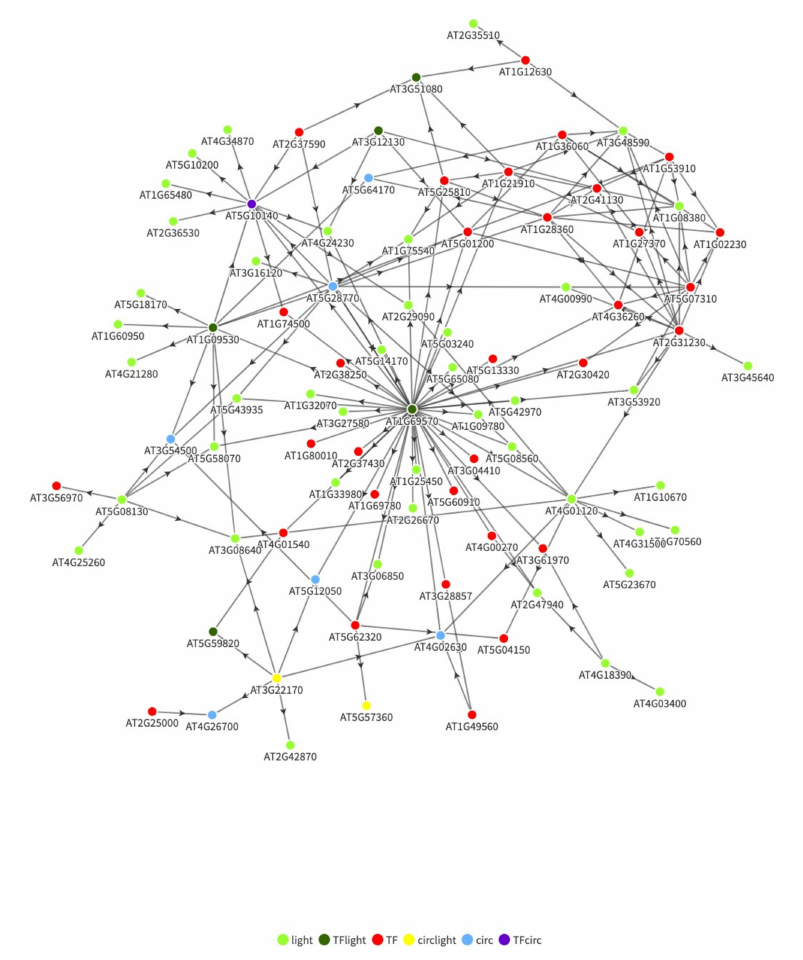
Figure 1. Regulatory network between top 50 TF and differentially expressed light and circadian related